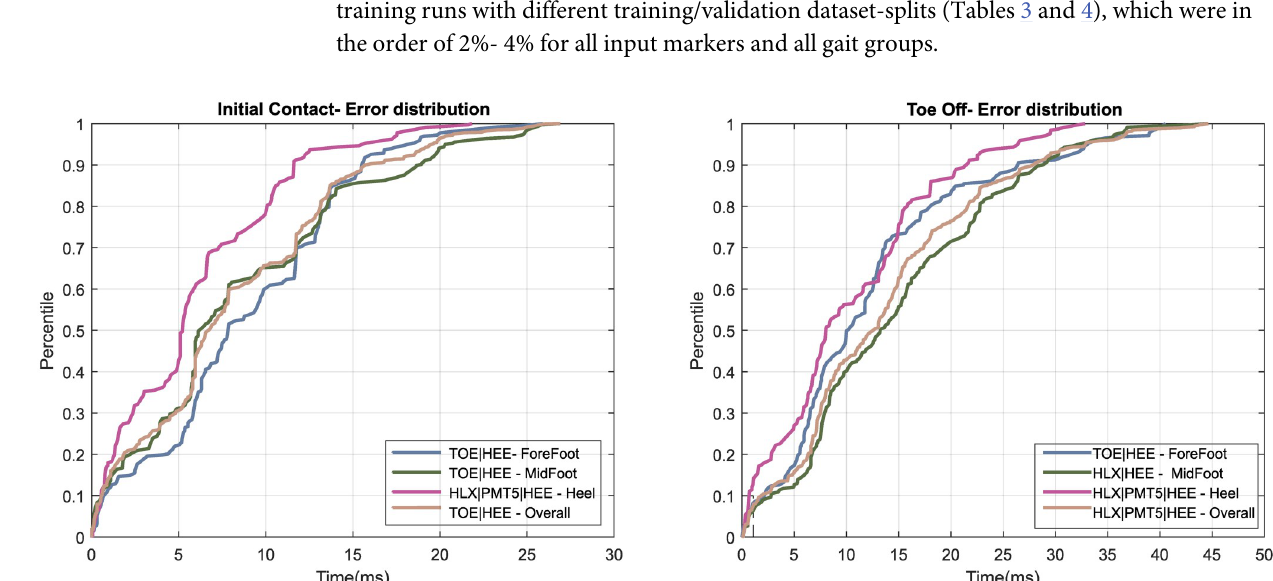
Fig 4. Percentile plot of the absolute prediction error in milliseconds of the best performing model for each gait group over the